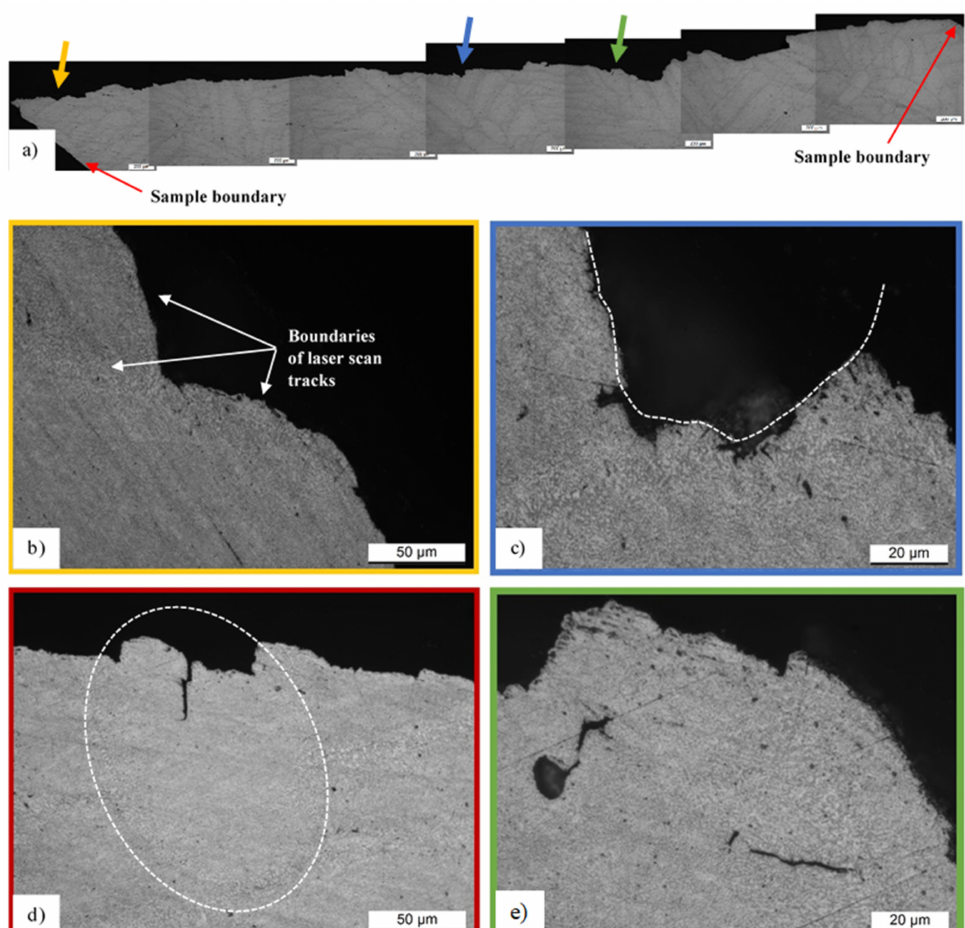
Figure 9. Fracture profile ( a ) of SL-90 (1) sample direct aged where the yellow, blue, red and green arrows indicate four different zones shown in ( b – e ) panels. The white dotted line ( c ) indicates a hypothetic laser scan track, while that in ( d ) indicates a molten